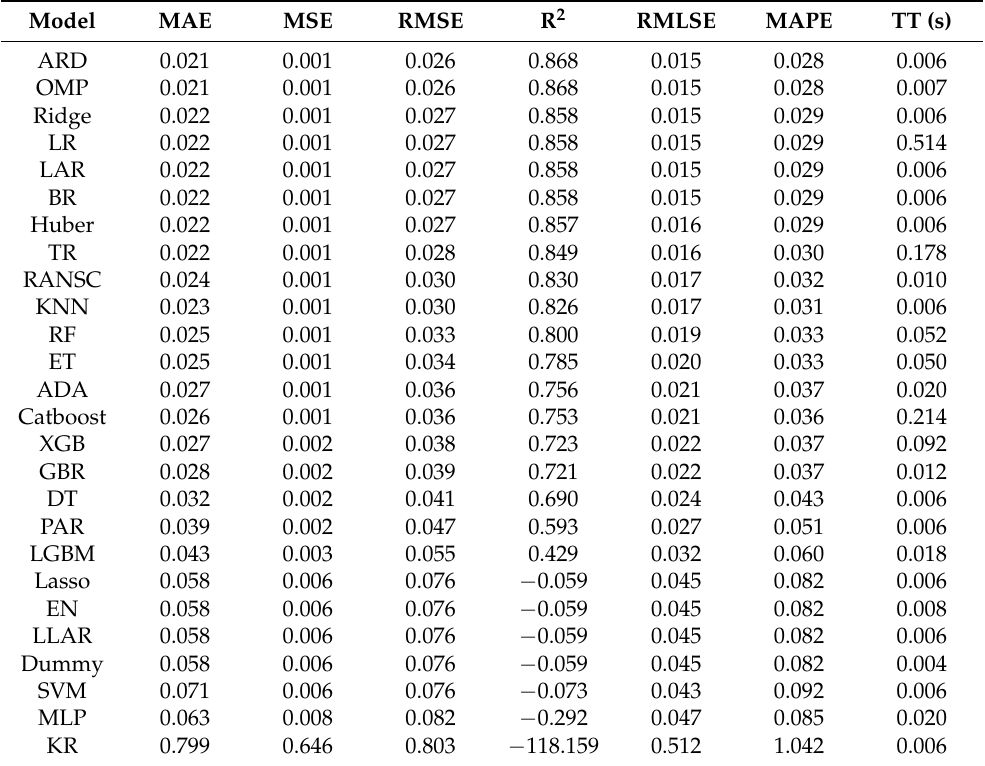
Table 11. Accuracy assessment of different estimation models based on RGB and MS indices.